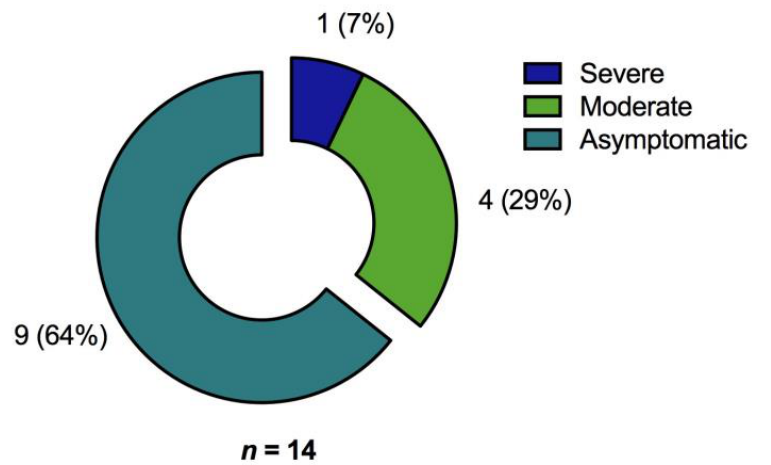
Figure 4. Proportion of convalescent patients with no detectable SARS-CoV-2 reactive T cells as determined by ELISpot analysis ( n = 14) after stimulation with the various S and M peptide pools with regard to primary COVID-19 severity [ n (%)] .